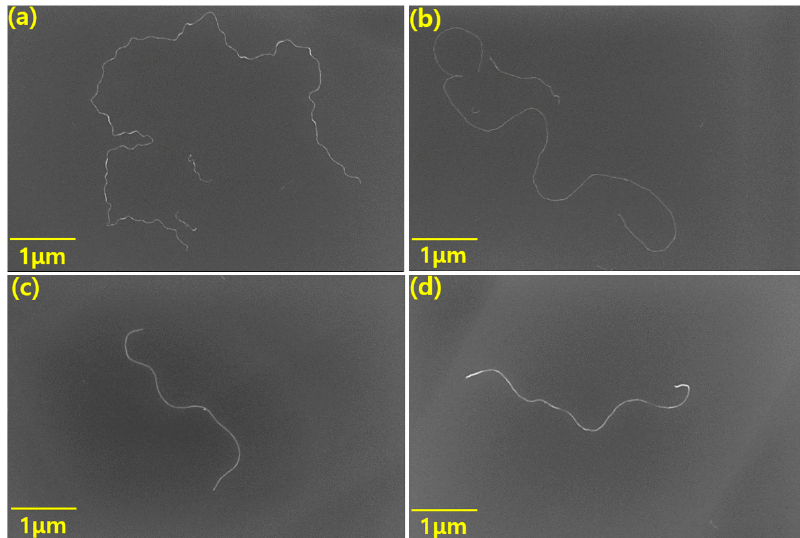
Figure 2. SEM images of MWCNTs: ( a , b ) in the case of high aspect ratio MWCNT (HCNT) with an average length of 12 μ m and ( c , d ) in the case of low aspect ratio MWCNT (LCNT) with an average length of 4.5 μ m.